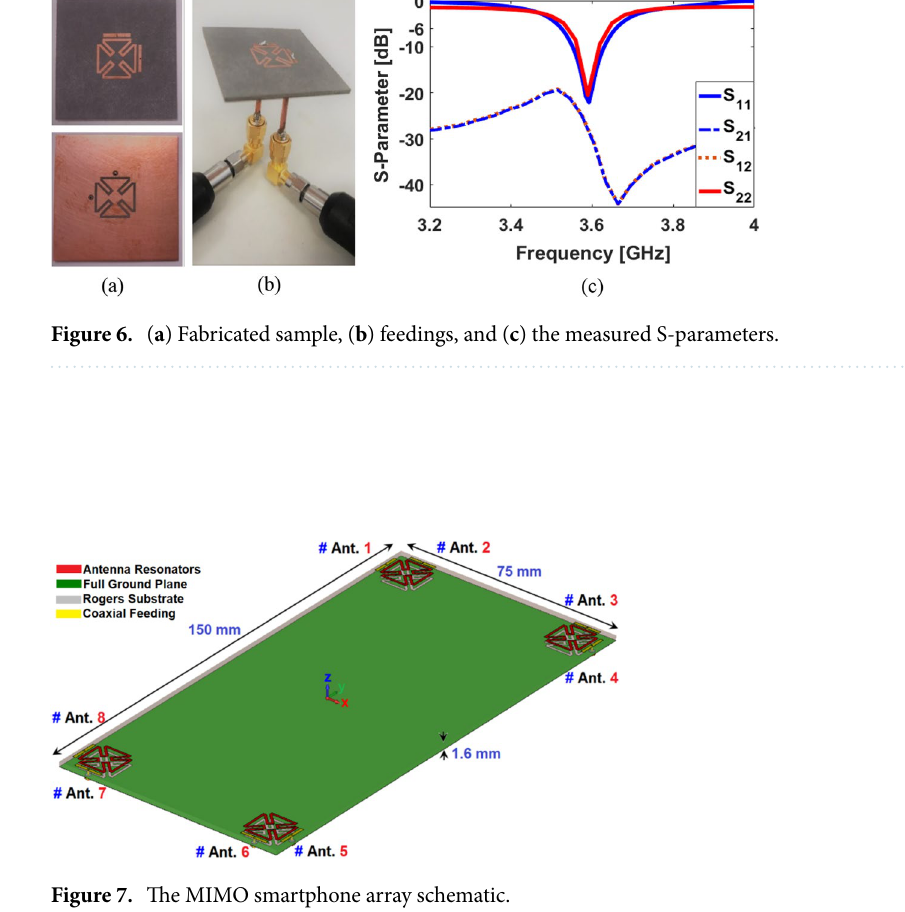
Figure 7. The MIMO smartphone array